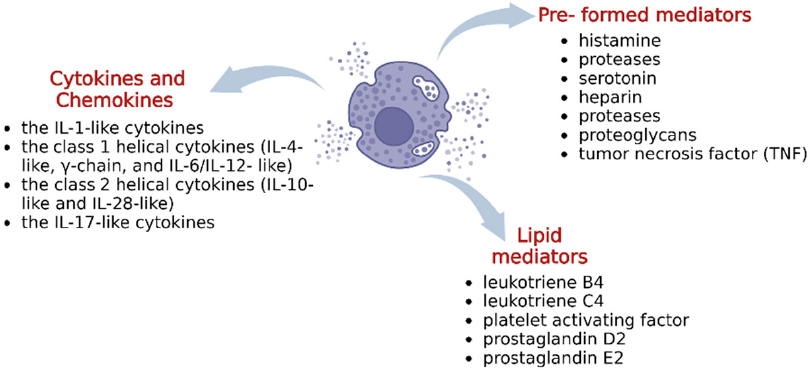
pro-inflammatory cells involved in different pathological conditions. plethora of mediators contained in their cytoplasmic granules which, after mast cell stimu- lation, are released into the extracellular space through different mechanisms of degranula- tion (Figure 2).